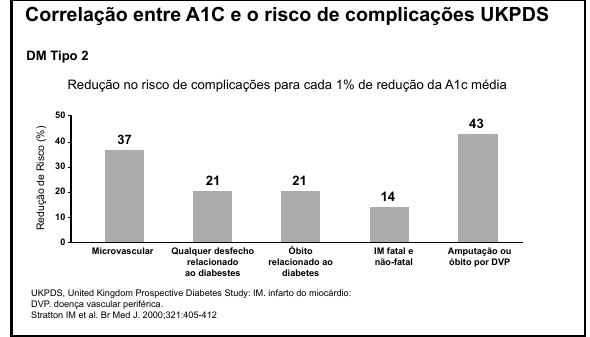
Figura 5 – Hemoglobina glicada e risco relativo de complicações micro e macrovas- culares: UKPDS (4,